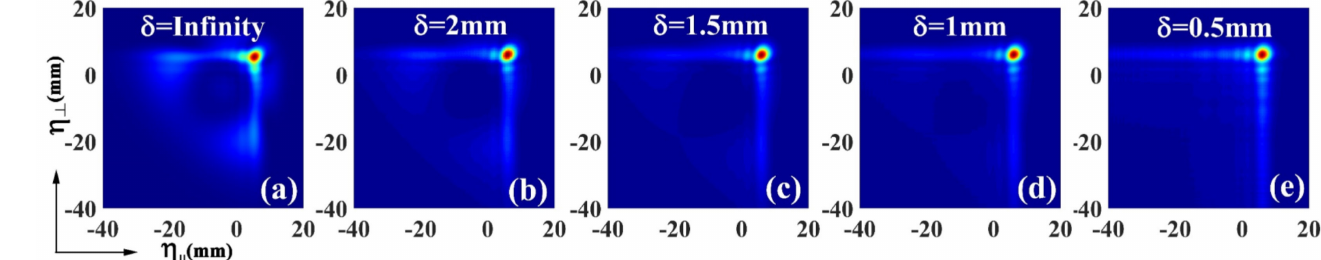
Figure 6. Density plots of the intensity distributions of ( a ) the fully coherent Airy beam and ( b – e ) PCABs for different source coherence widths. The beam is obstructed by an opaque obstacle in the source plane, and the receiver plane is at Z = 160